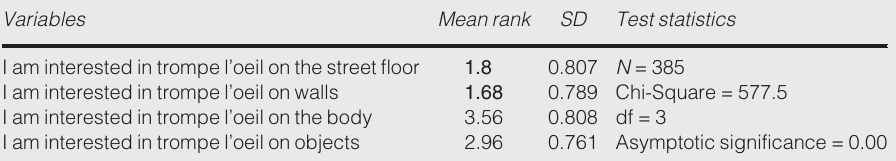
Table 3 The output of the Friedman test for the investigation of priority of place of trompe l ’ oeil from the tourists ’